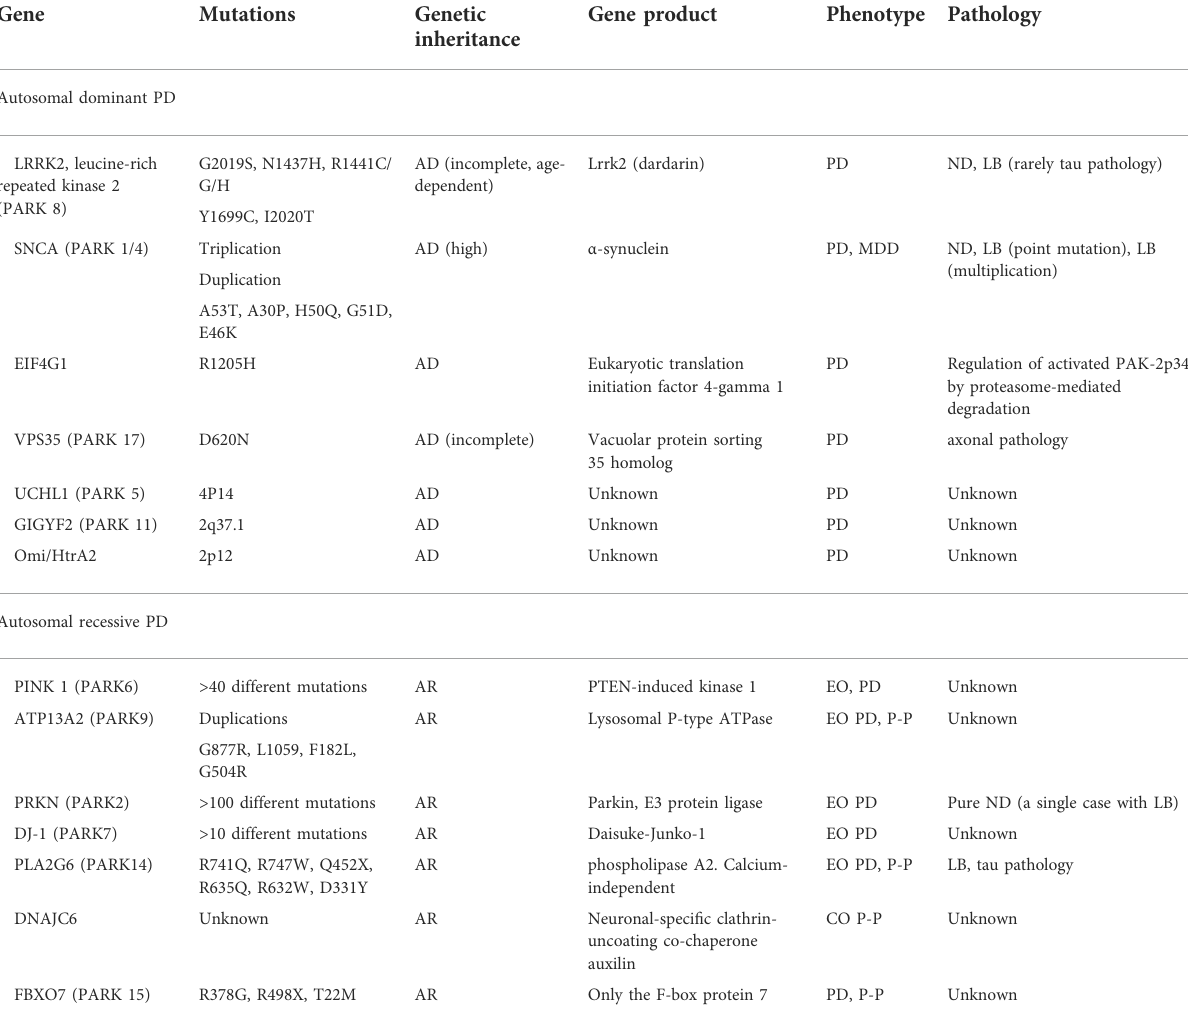
TABLE 1 Genetic dysregulations of different types of genes associated with PD. Gene Mutations Genetic